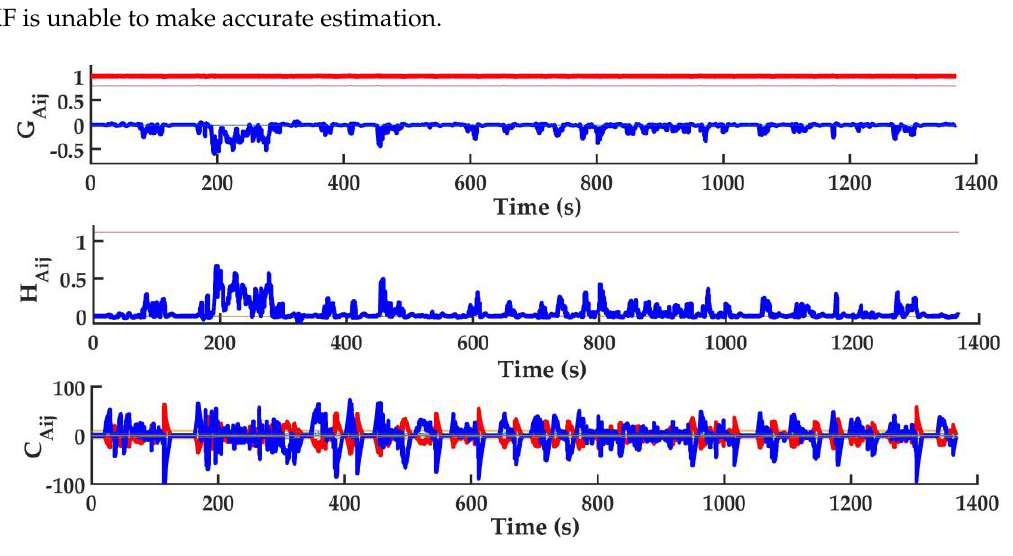
Figure 7. G A , H A and C A variation of AMPC.